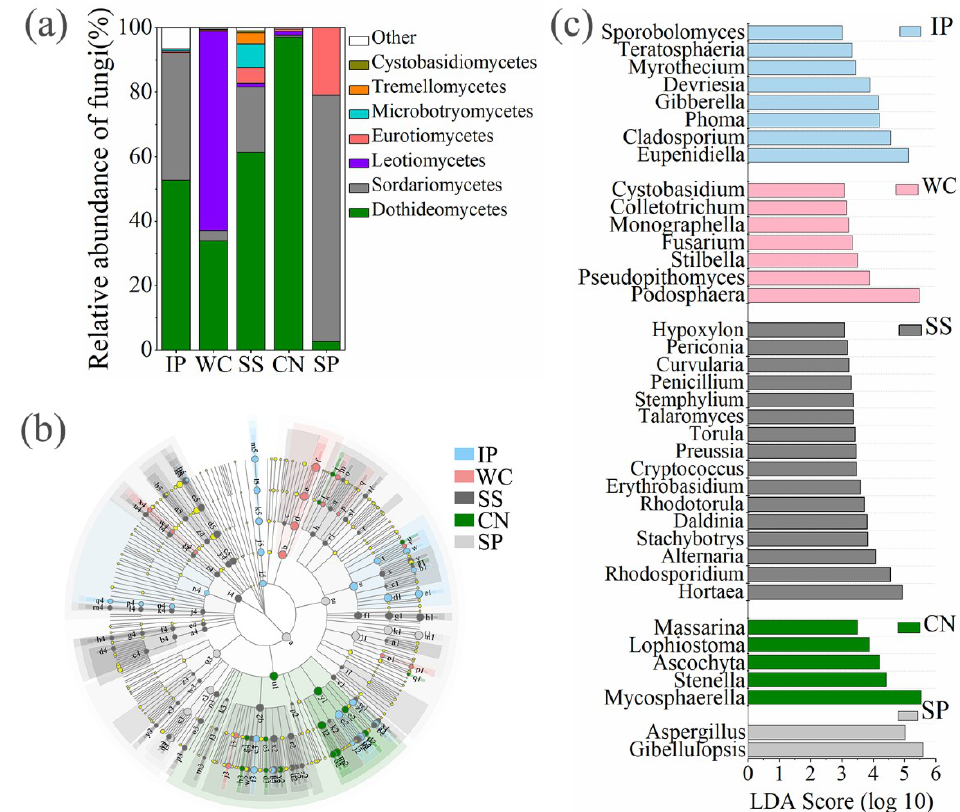
Figure 4. The relative abundances of fungi at class level of five different phyllosphere samples ( a ). Taxonomic differences among different phyllosphere samples by a linear discriminant analysis (LDA) coupled with effect size (LEfSe). Taxonomic representation of statistically and biologically consistent differences among different phyllosphere samples ( b ). LDA scores were calculated by the LDA effect size, using the linear discriminant analysis to assess the effect size for each differential genera with relative abundance of the taxa comprising more than 0.1% of the fungal sequences in each sample ( c ). IP indicates Ipomoea pes-caprae , WC indicates Wedelia chinensis , SS indicates Scaevola sericea , CN indicates Cocos nucifera , SP indicates Sesuvium portulacastrum .